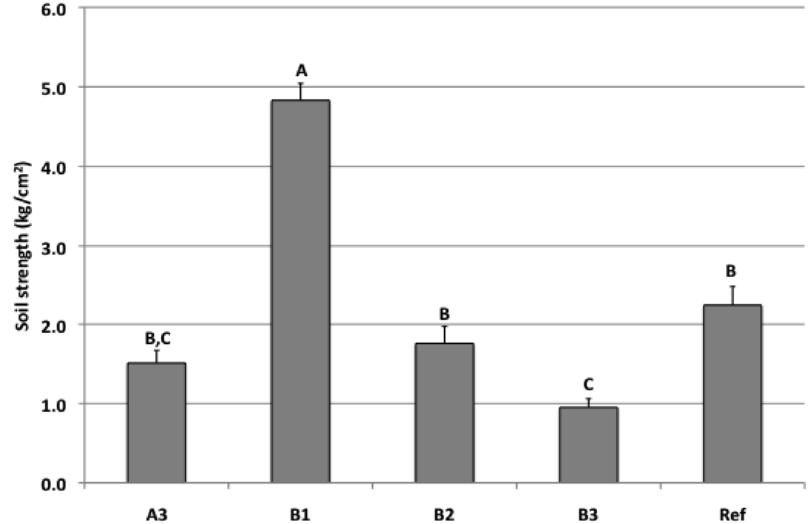
Figure 5. Surface soil strength using a hand held penetrometer. Different letters indicate a significant difference α = 0.05. Error bars represent standard error of the mean.